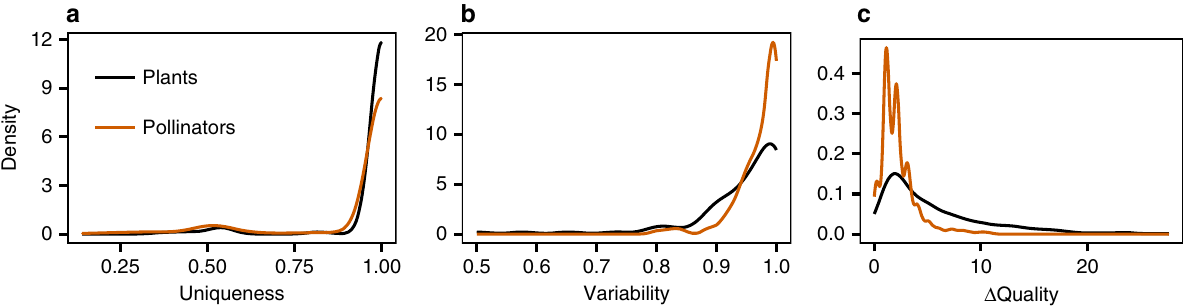
Fig. 2 Analysis of species ’ positions across networks. a Uniqueness of the position of plant and pollinator species within networks. b Variability of species' position across networks, including only plant and pollinator species that appear in multiple networks during a season. c Decrease in alignment quality due to the fi xing of individual species that are common across